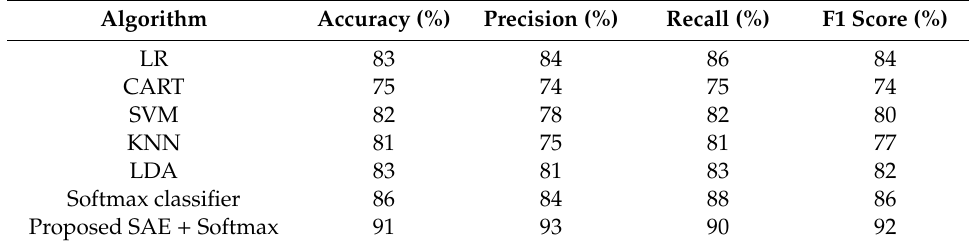
Table 1. Performance of the proposed method and other classifiers on the Framingham dataset.